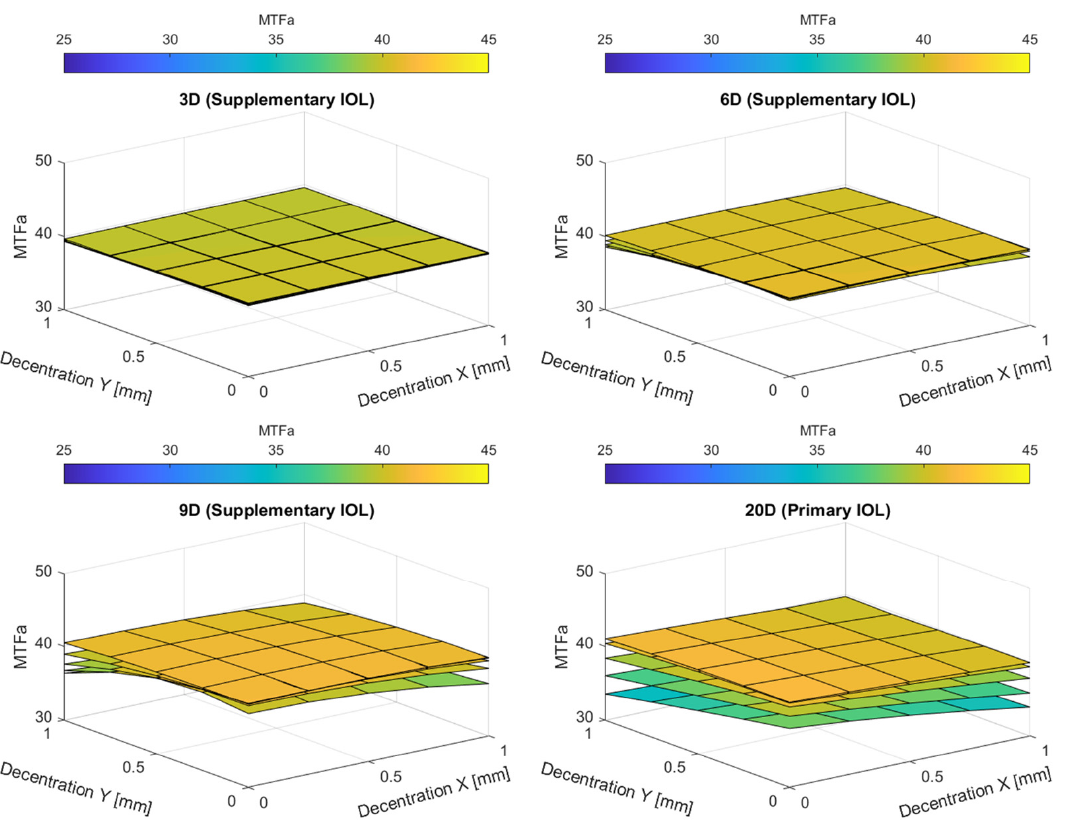
Figure 2. The effect of decentration and tilt on the optical quality of a 20 D capsular fixation IOL, as well as 3, 6, and 9 D sulcus-fixated IOLs in polypseudophakia. The imaging performance was quantified with the area under the modulation transfer function (MTFa). Each figure’s top and bottom surfaces correspond to a condition with zero and 10 ◦ tilt, respectively. For the 20 D IOL, a 2.5 ◦ tilt increase resulted in a gradual degradation of the optical quality, creating five distinct surfaces of the MTFa change.